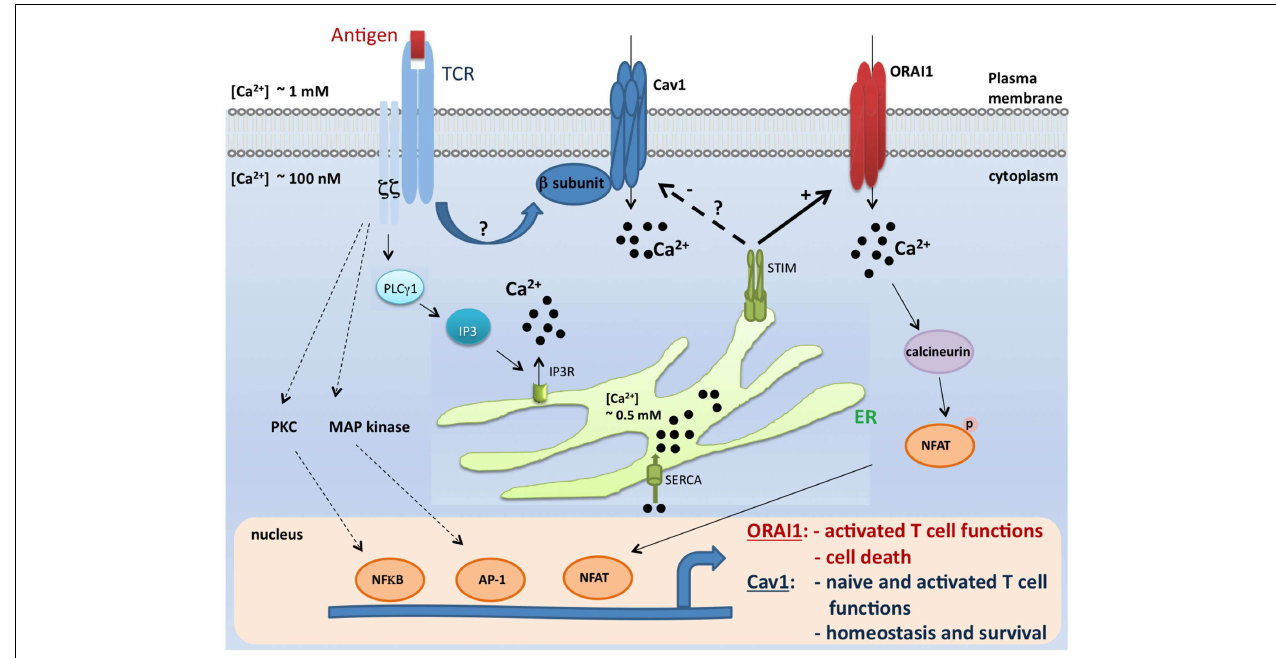
FIGURE 1 |A model for coordinated control of Ca v 1 and ORAI1 channels inT lymphocytes . Antigen encounter byT cells results in the activation of numerous pathways including the Ca 2 + pathway. Mechanisms of Ca 2 + influx through two major Ca 2 + -permeable channels, Ca v 1 and ORAI1, are depicted in this scheme. During the course of biological functions that require activation of the STIM/ORAI pathway (such as effector functions and apoptosis), STIM1 blocks Ca v 1 channel activity and all dependingT cell functions. In contrast, this inhibitory effect would be lifted when Ca v 1-dependentT cell functions